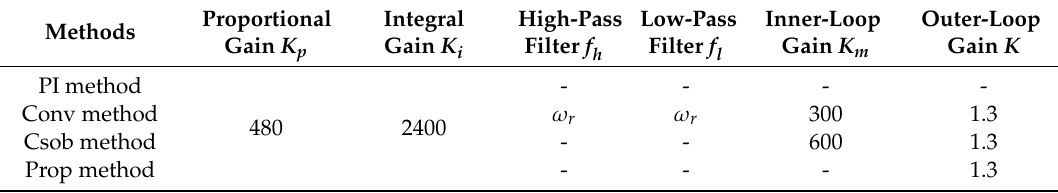
Table 6. Control parameters of the four methods with motor-side